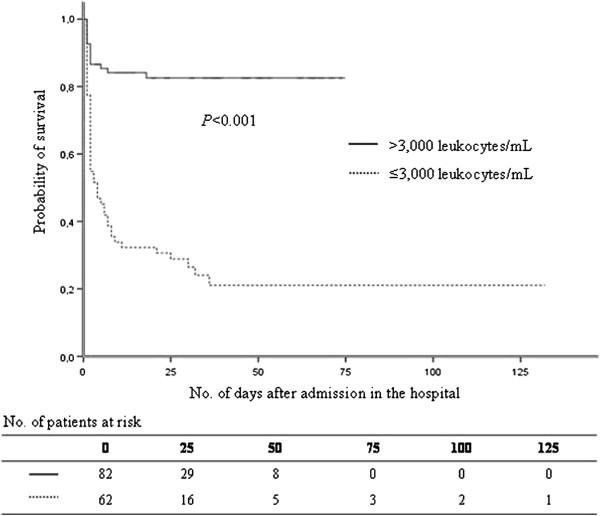
Probability of survival among patients with Panton-Valentine leukocidin-positive Staphylococcus aureus pneumonia, according to leukocyte count.